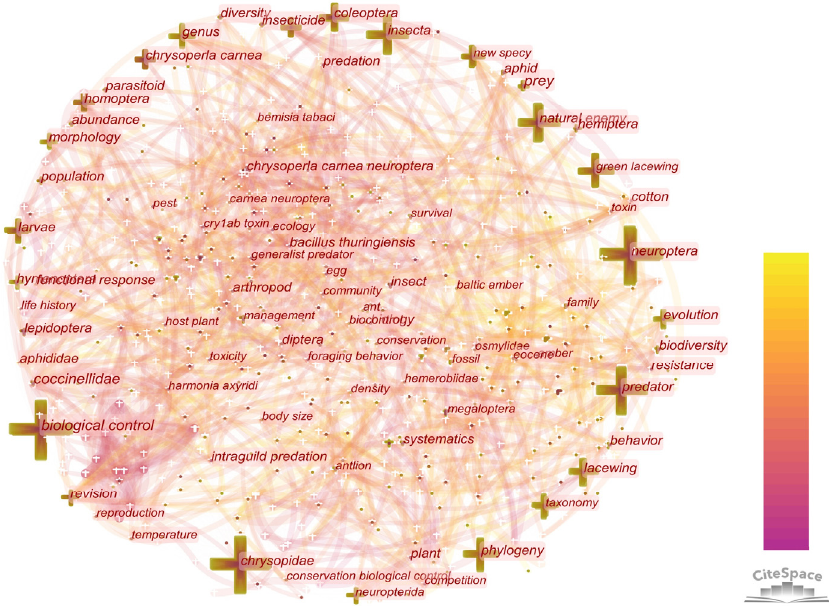
Figure 10. Co-occurring keywords map. The node size represents the keyword frequency. The line between nodes represents the co-occurrence between keywords. Table 9. Top 10 keywords in terms of frequency and centrality. Rank